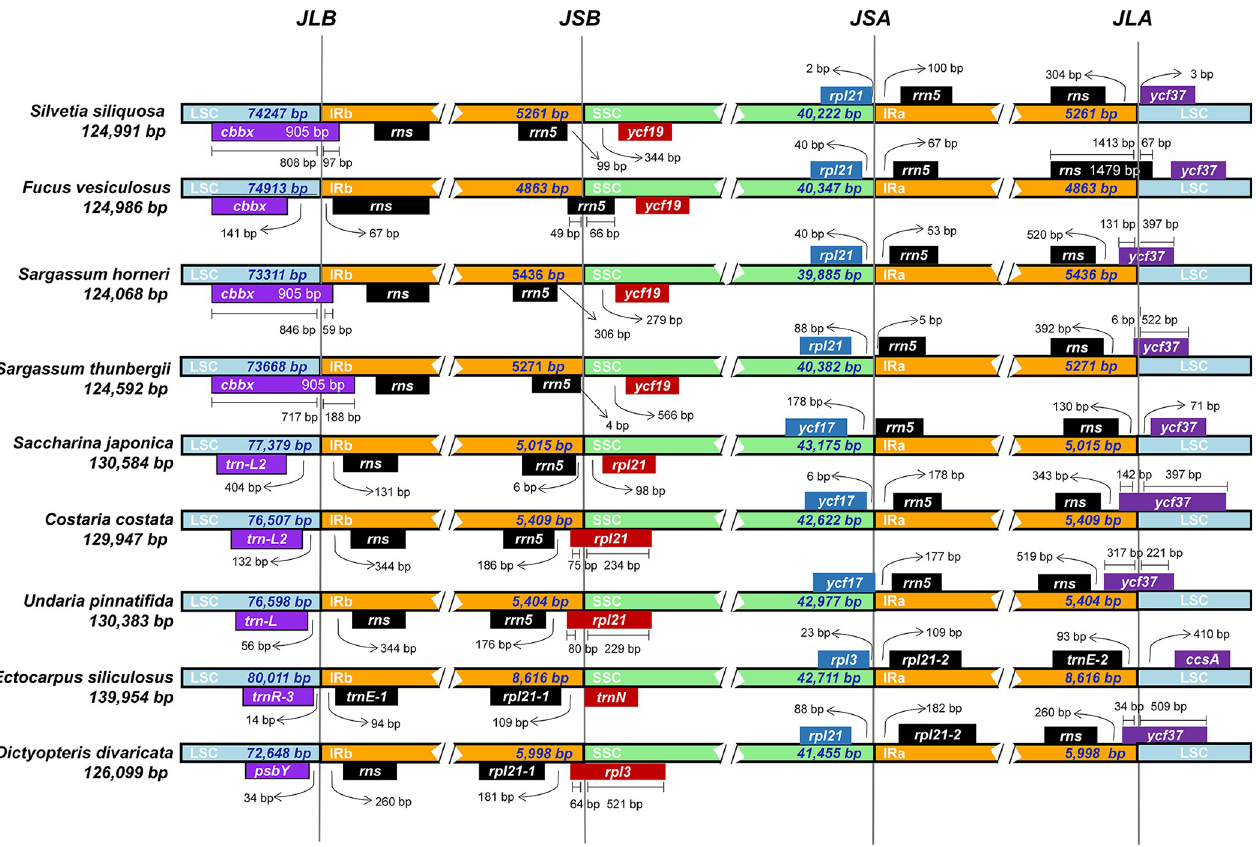
Fig 5. Comparison of the borders of LSC, SSC and IR regions among Phaeophyceae chloroplast genomes.